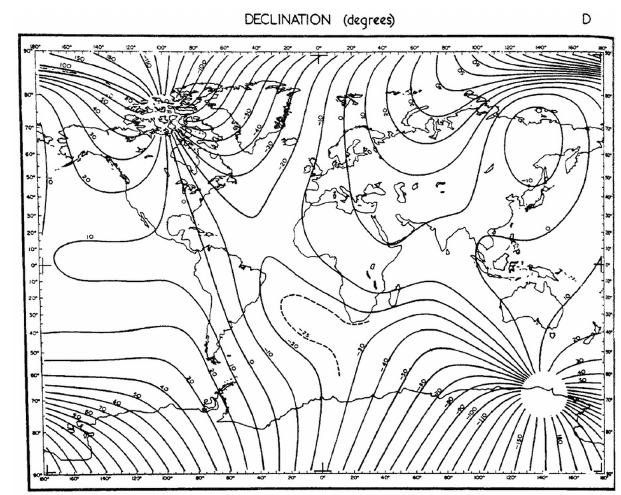
Figure 13. The world map of geomagnetic declination in degrees, compiled using the Earth’s magnetic field model IGRF for epoch 1965.0 (Zmuda,